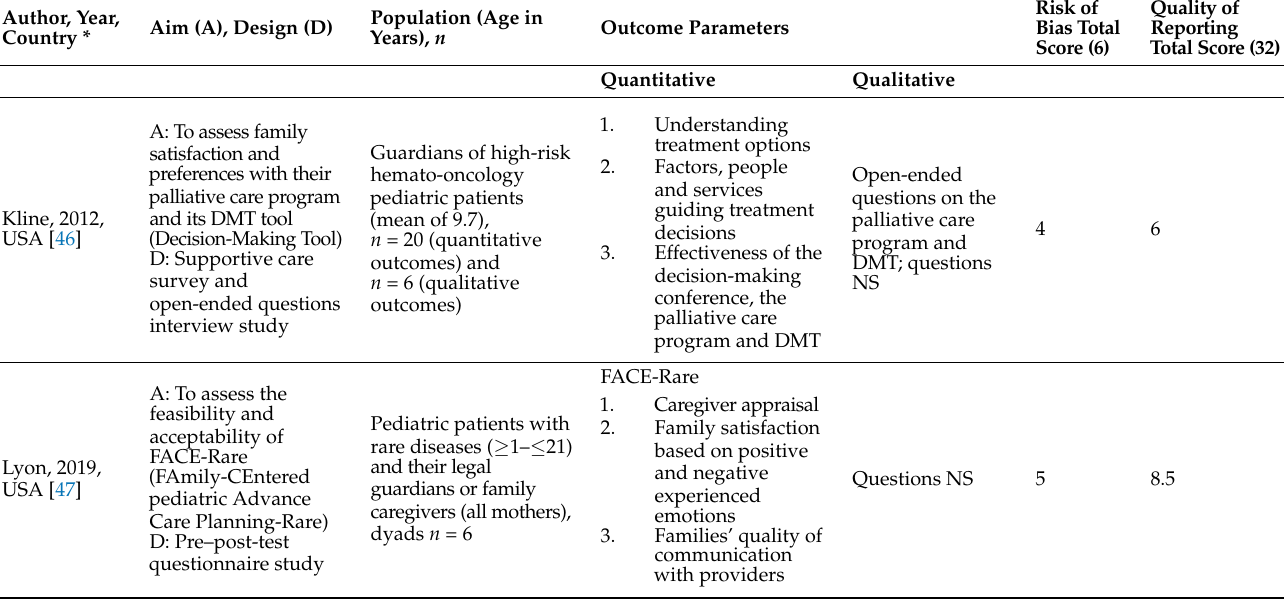
Table 4. Evidence from mixed-method